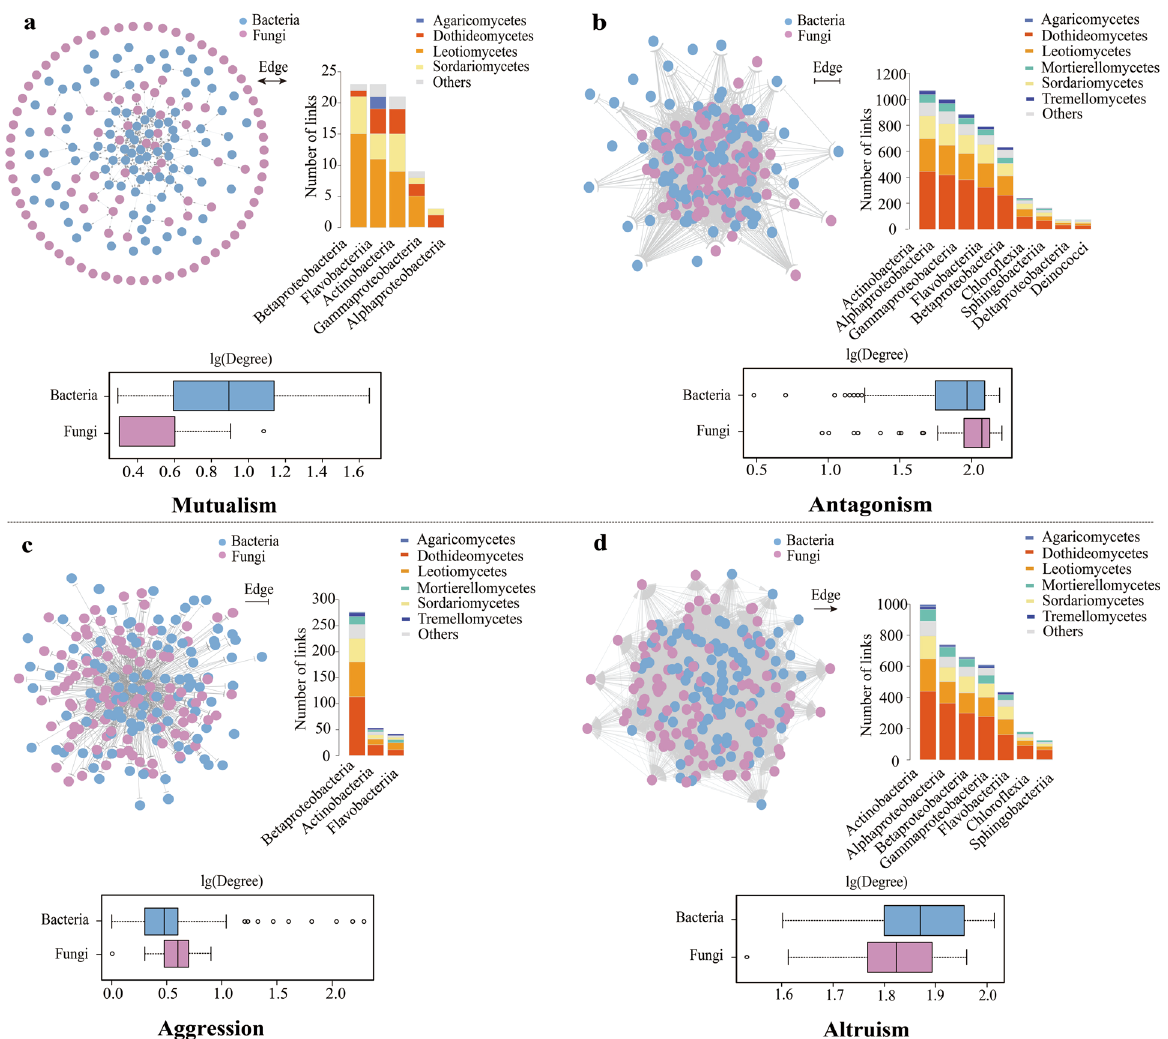
Fig. 1 Microbial descriptor-based network at the OTU level of the root microbiome in Arabidopsis thaliana . a Z mu -based mutualism network. b Z an -based antagonism network. c Z ag -based aggression network. d Z al -based altruism network. In each network, bacteria and fungi are distinguished by different colors. The network analysis was performed in the “ igraph ” R package and visualized in Cytoscape v3.7.1. The number of links between root inter-kingdom microbes was given at the right. Bacterial and fungal OTUs were grouped at the class level and sorted according to the number of edges between bacteria and fungi within each network. In boxplots, the fungal and bacterial degrees were calculated to determine the relative importance of bacteria and fungi in each